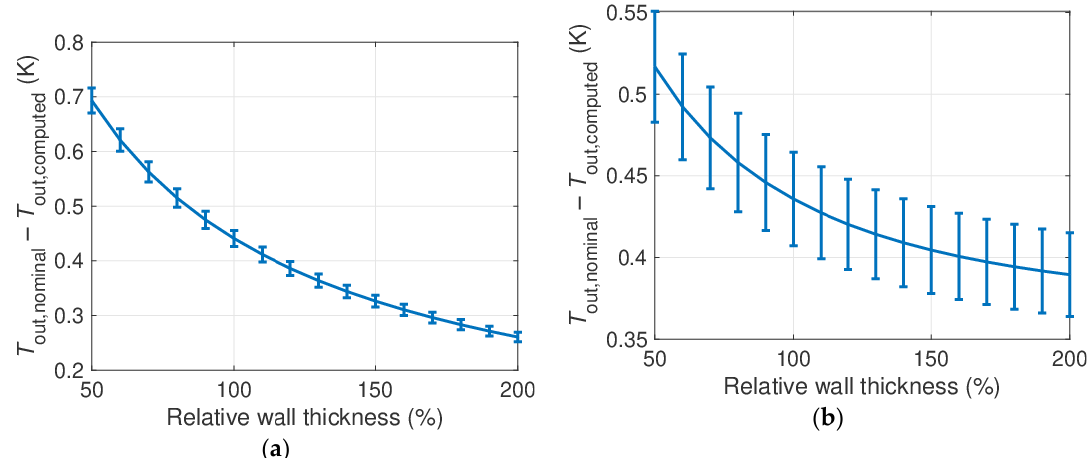
Figure 16. Difference between design outlet temperature (328 °C) and its computed value, as a function of the wall thickness, for the case with radiation and adiabatic PbLi manifolds: ( a ) FW manifolds; ( b ) BZ manifolds.